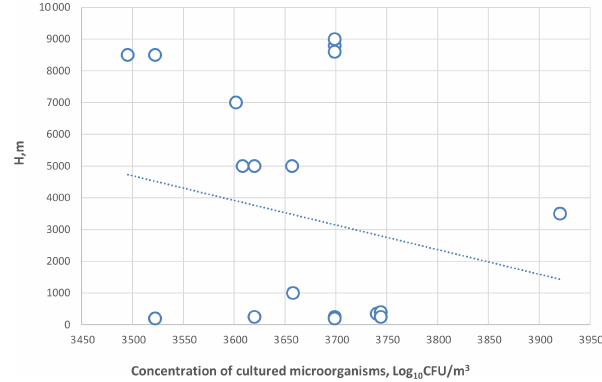
Figure 18. Concentration of cultivated microorganisms (colony- forming units, CFU) in atmospheric aerosol sampled over the Rus- sian Arctic